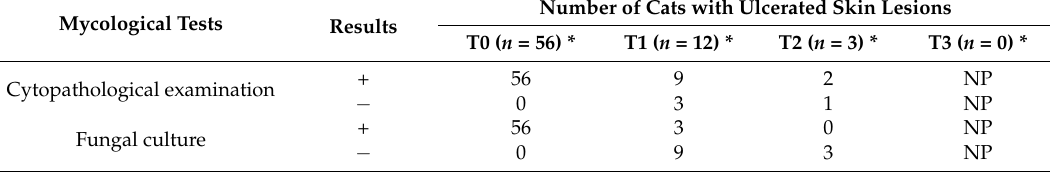
Table 3. Results of fungal culture and qualitative cytopathological examination from ulcerated skin lesions of cats with sporotrichosis during treatment with itraconazole and potassium iodide, Lapclin- Dermzoo/INI/Fiocruz (2013–2015).